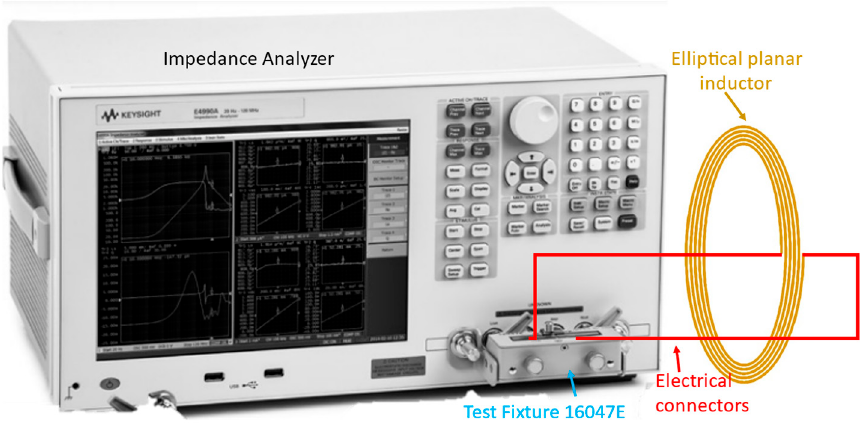
Figure 6. Inductance and Impedance measurement setup.